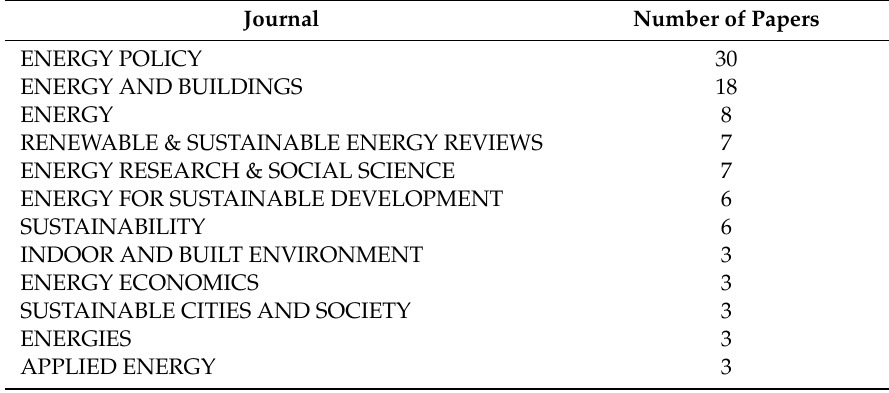
Table A9. Top 10 journals on the field (all the journals with 3 papers were